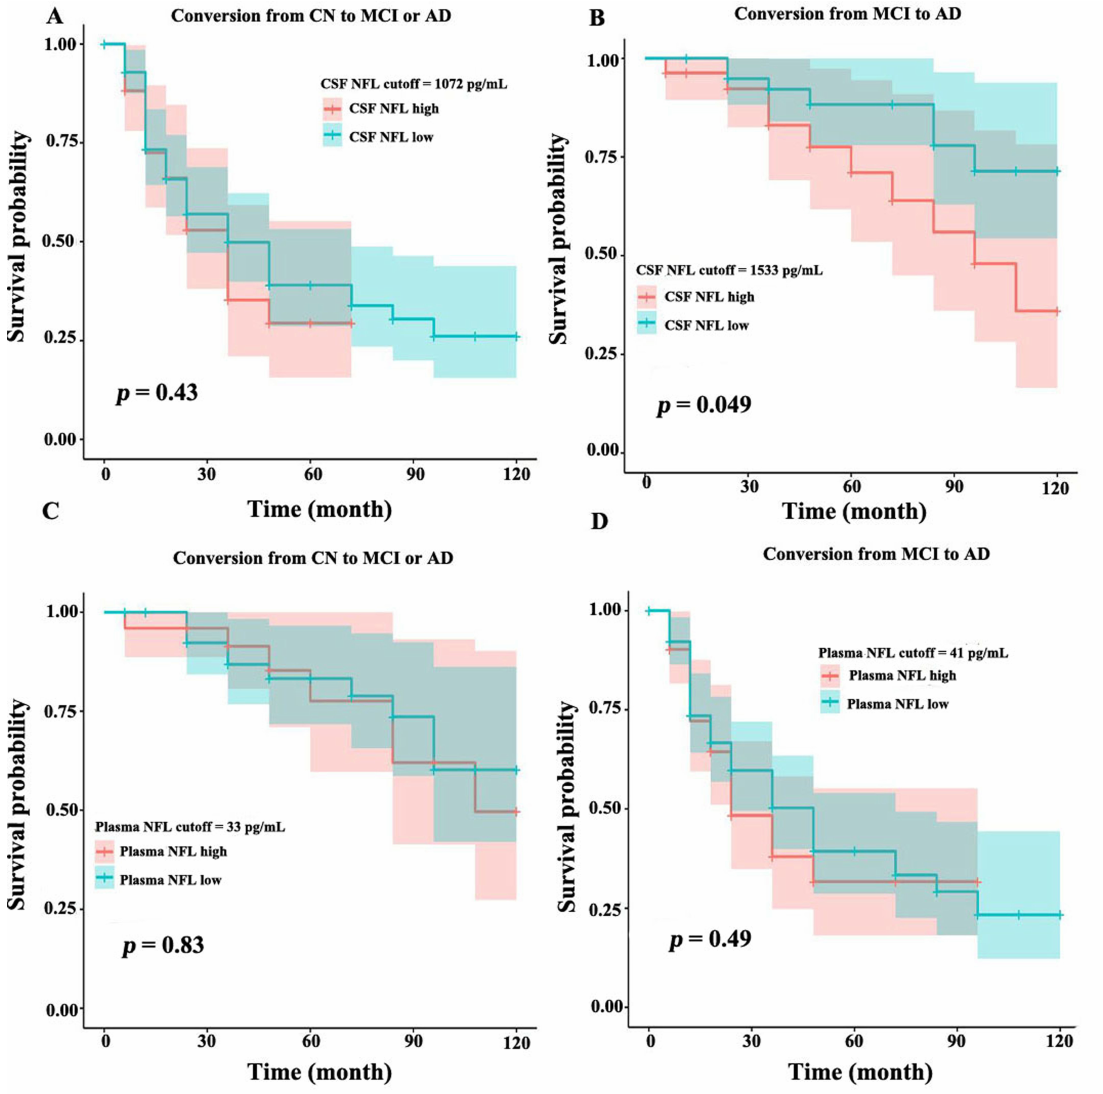
Fig. 5. Baseline CSF and plasma NFL as predictors of conversion from CN to MCI or AD and MCI to AD. Conversion from CN to MCI or AD (A) and MCI to AD (B) as a function of CSF NFL. Conversion from CN to MCI or AD (C) and MCI to AD (D) as a function of plasma NFL.